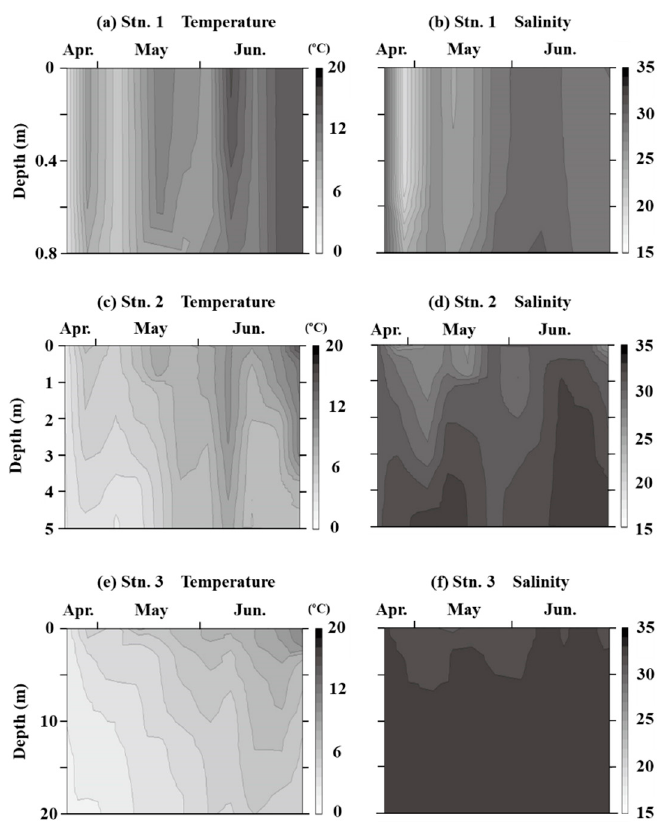
Figure 2. Temporal changes of water temperature ( a , c , e ) and salinity ( b , d , f ) monitored at the three stations in Akkeshi-ko Estuary (Stn. 1) and Akkeshi Bay (Stn. 2 and Stn. 3). The surface water temperature at Stn. 2 fluctuated in the range of 3.1 ◦ C (21 April) to 14.8 ◦ C (23 June, Figure 2c). The salinity varied from 27.0 on 27 April to 30.9 on 23